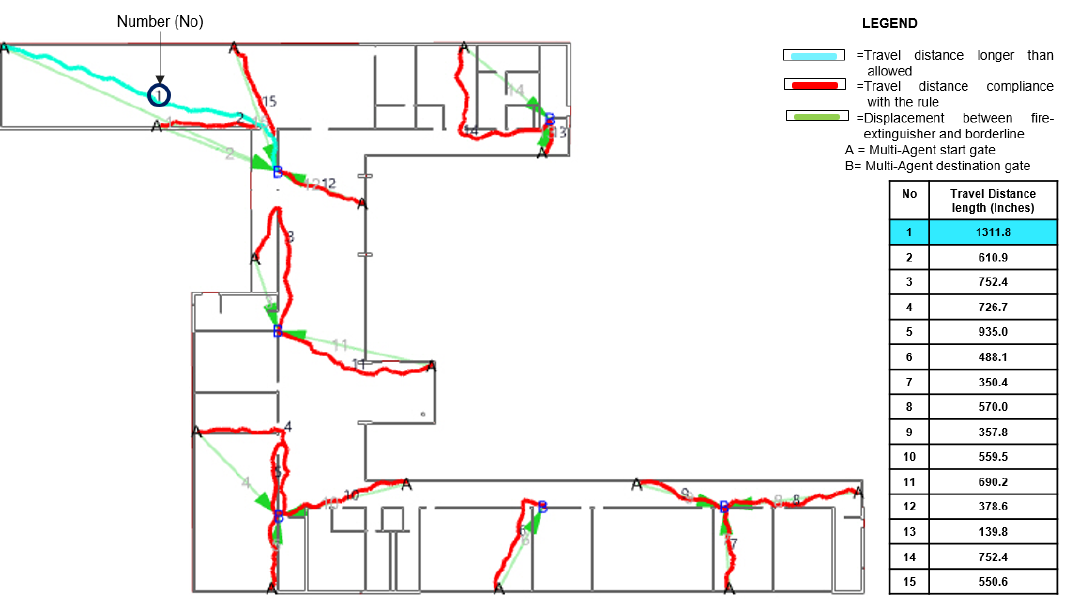
Figure 6. Multi-Agent Simulation for the Con-fire Safety Planning.